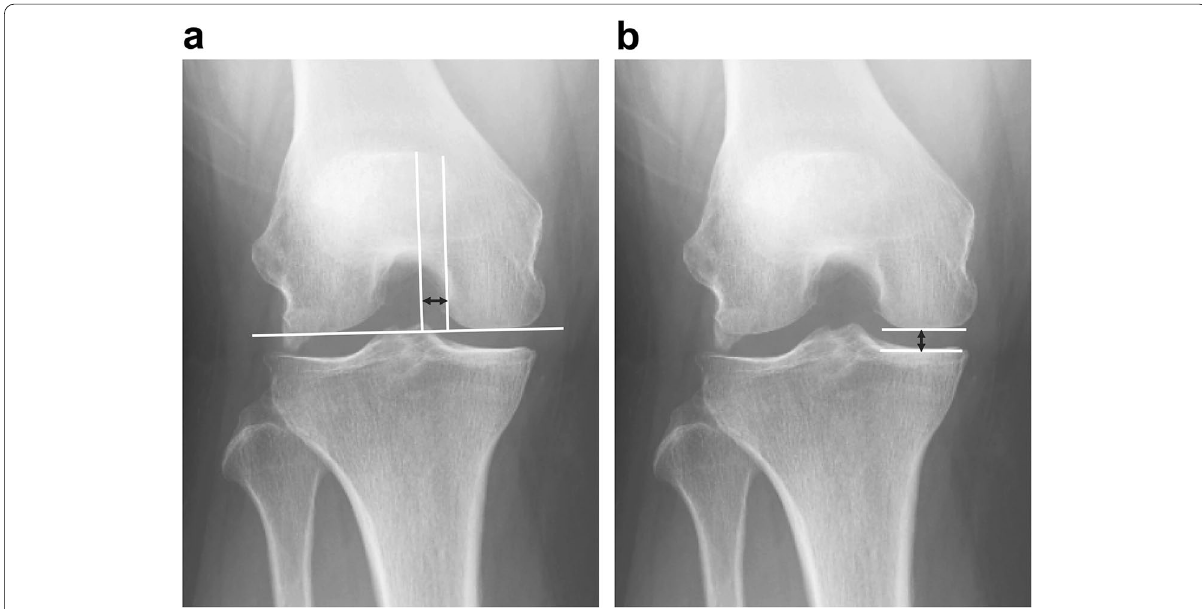
Fig. 2 Non-weight-bearing tunnel view measurement; medial tibial eminence–medial femoral condyle distance; medial tibiofemoral joint width. a The medial tibial eminence (MTE) line was drawn perpendicular to the line tangent to the medial and lateral condyles. The medial femoral condyle (MFC) line is perpendicular to the medial and lateral condyles of the femur and tangent to the medial side of the femur. The MTE–MFC distance is indicated by a black arrow. b The medial tibiofemoral joint (MTFJ) width was measured from the center of the medial femoral condyle to the center of the medial tibial plateau. The MTFJ width is indicated by a black arrow